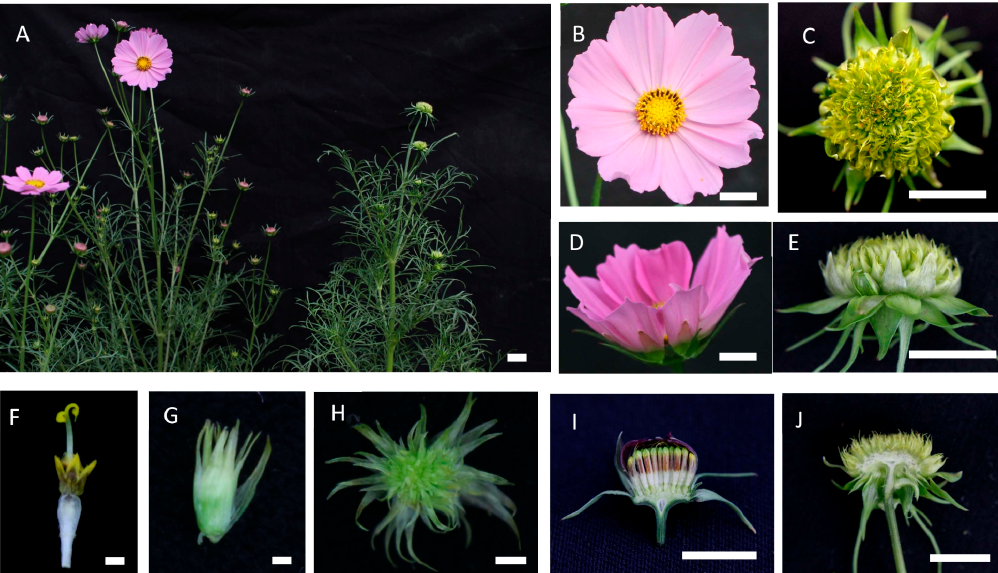
Figure 1. Morphological observation of wild-type and gh cosmos ( A ) Wild-type cosmos (left) and gh cosmos (right); ( B , D , I ) mature capitulum of wild-type cosmos; ( F ) disc flower of wild-type cosmos; ( C , E , J ) mature capitulum of gh cosmos; ( G ) separated tightly-folded structure is unwrapped in gh cosmos; ( H ) separated tightly-folded structure in gh cosmos. Scale bars of A–E, I, J = 1 cm; scale bars of F, G, H = 1